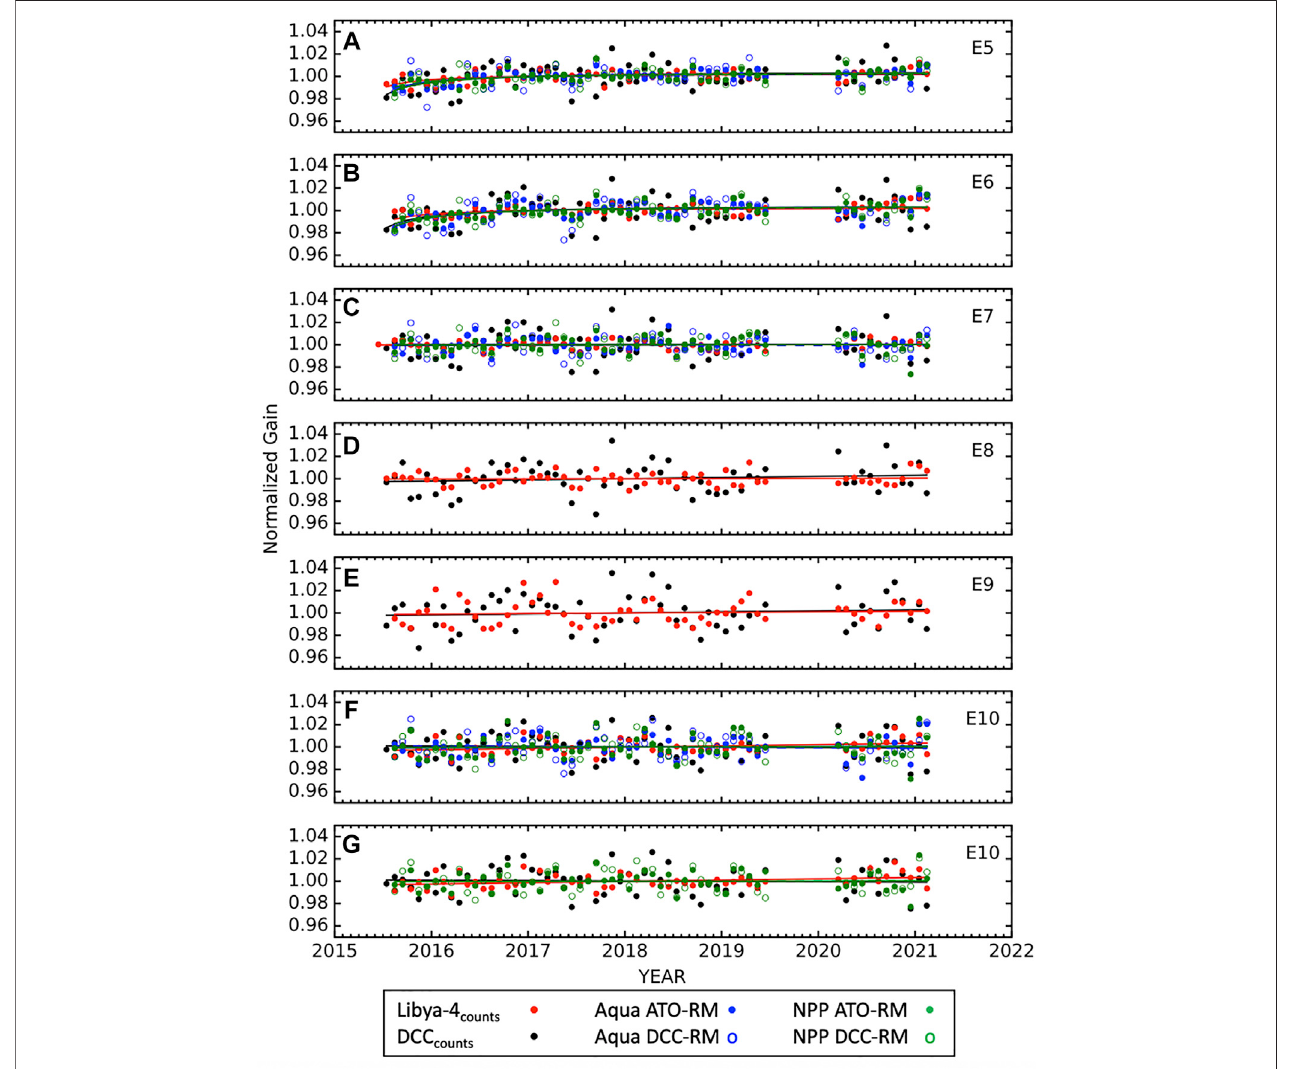
FIGURE 7 | Time series of the EPIC band normalized response showing the inverse of the DCC counts (black) and Libya-4 counts (red), as well as the Aqua-MODIS (blue), and NPP-VIIRS (green) monthly gains. Filled circles and solid lines for Aqua-MODIS and NPP-VIIRS represent ATO-RM, and open circles with dashed lines represent the DCC-RM counterparts. (A) through (E) show the corresponding E-5, E-6, E-7, E-8, and E-9 time series, respectively. (F) shows DCC counts , Libya-4 counts , ATO-RM, and DCC-RM with M Aq -1 and V NPP -I1, (G) same as (F) except V NPP -M7 instead of M Aq -1 and V NPP -I1.